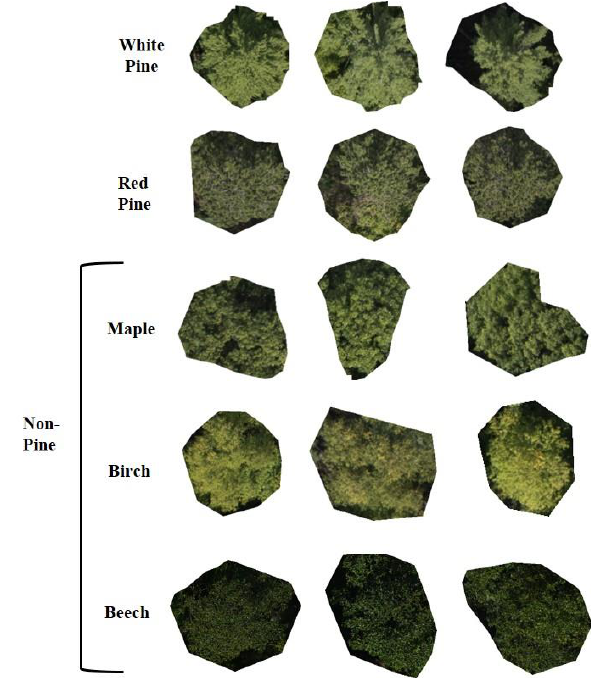
Figure 8. Examples of training images